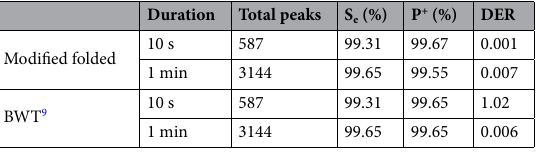
Table 5. Performance of ECG detectors on short and medium-length database.